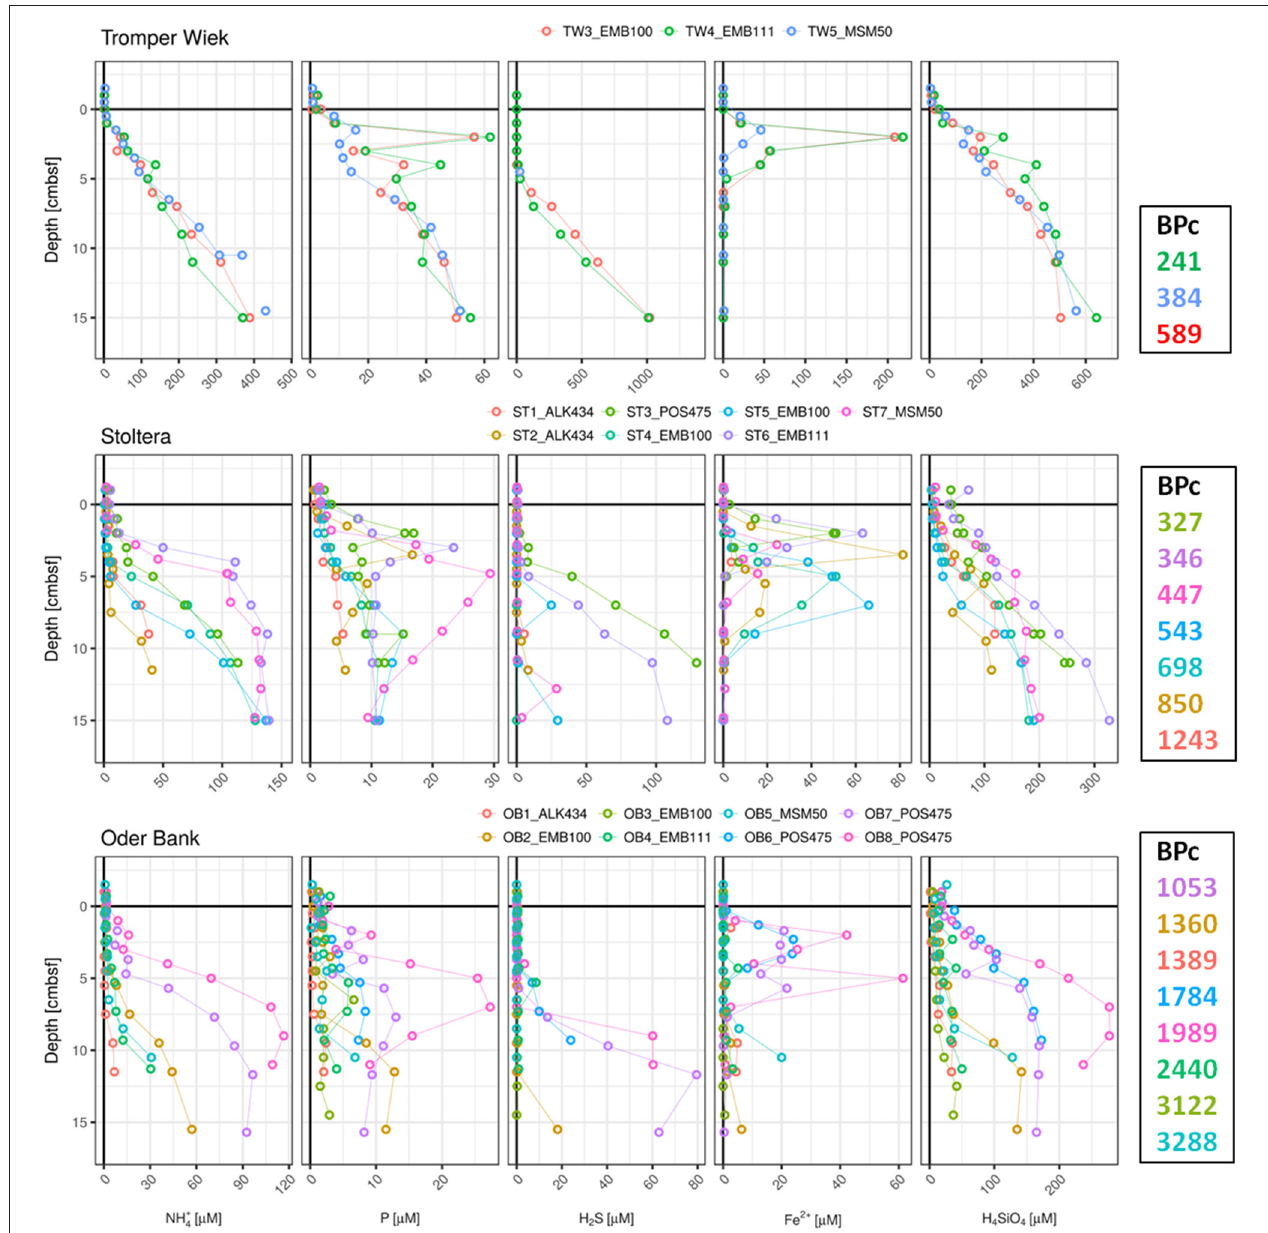
FIGURE 3 | Pore-water profiles of NH + 4 , P, H 2 S, Fe 2 + , and H 4 SiO 4 for sediment cores collected from silt and sand stations plotted against the BPc values defined by the colonizing benthic macrofauna community. Note the differences in axes scales. Cores are labeled according to sampling station (first 2 characters), followed by one character indicating core ID number, whereas the last 6 characters represent the cruise ID (respective seasons are indicated in Table 1 ).